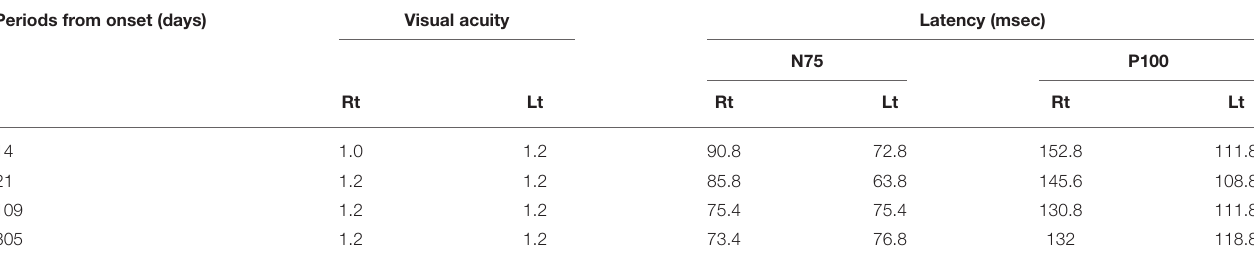
TABLE 2 | The latency of N75 and P100 components in pattern visual evoked potentials. Periods from onset (days) Visual